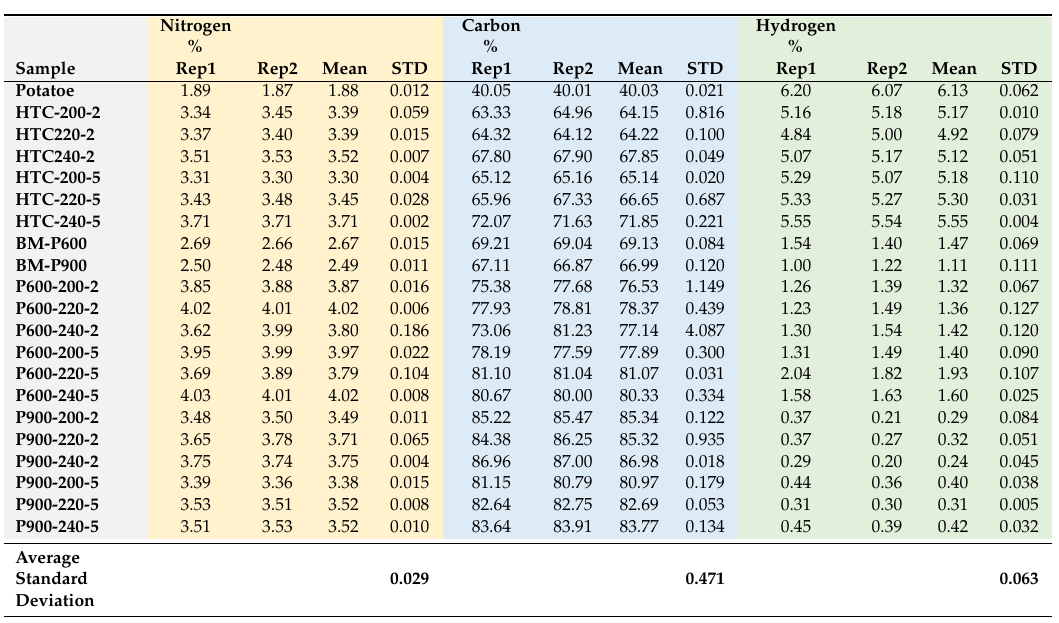
Table A2. Statistical analysis of the Elementary